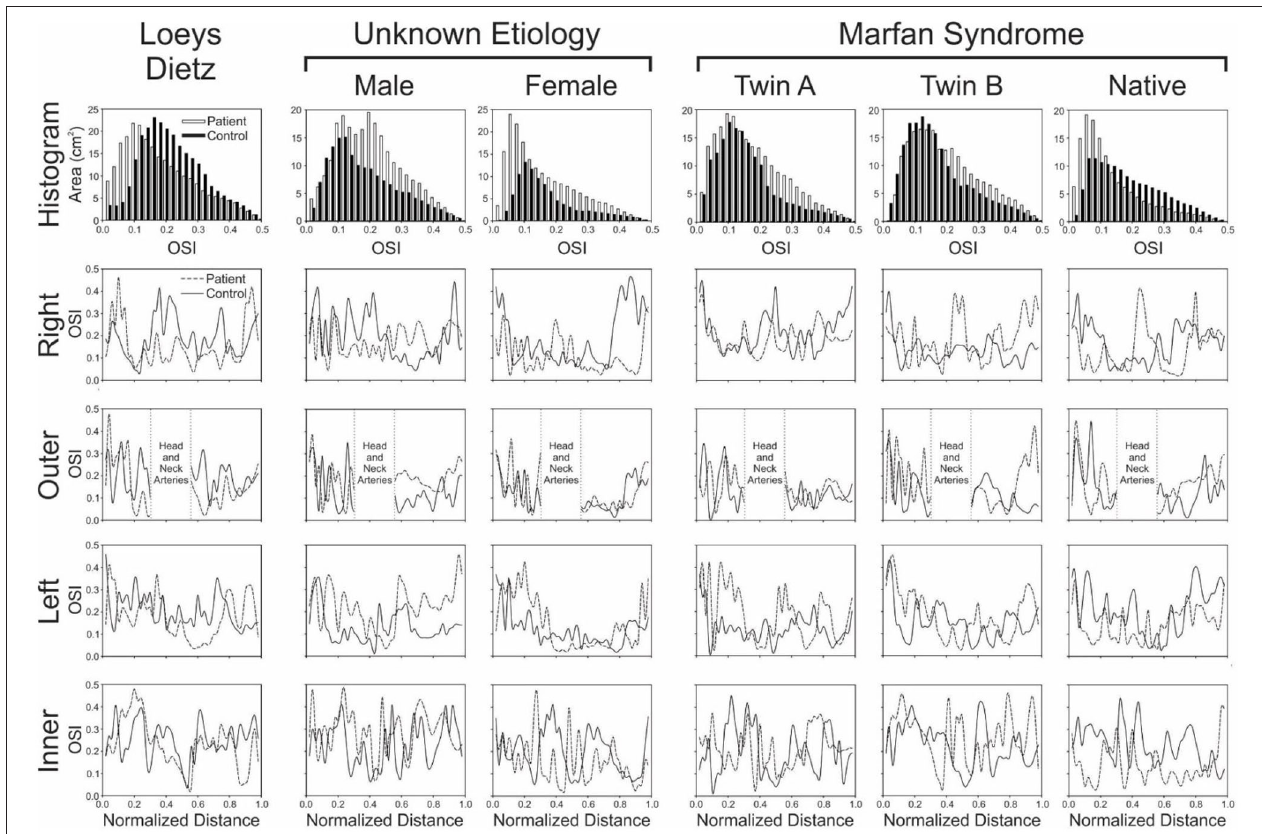
FIGURE 4 | Local quantification of oscillatory shear index (OSI) results. The top row shows histograms (0.2 unit bins) of the area (cm 2 ) from each model surface exposed to OSI values from 0 to 0.5 (connective tissue disease = solid bars; age- and gender-matched controls = hollow bars). Longitudinal OSI distributions along the outer, anatomic right, anatomic left, and inner curvatures of the aorta are also shown in subsequent rows for the patients with various connective tissue disease (dashed lines) vs. their associated age- and gender-matched controls (solid lines). Higher OSI values are generally thought to promote atherogenesis, so skewing of histogram results toward higher values could be interpreted as less ideal, as could overall higher values of OSI along the outer, anatomic right, anatomic left, and inner curvatures of the